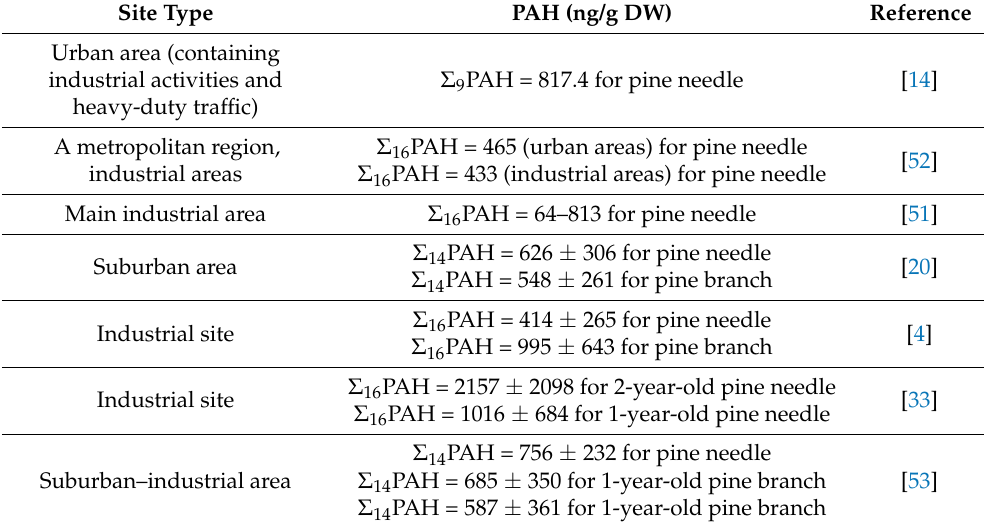
Table 1. Some PAH biomonitoring data from pine needles and